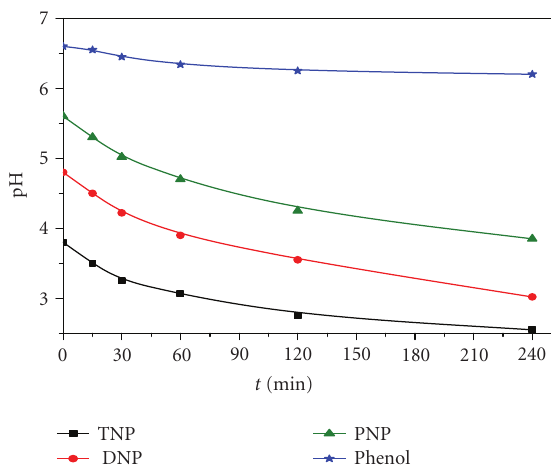
Figure 7: Kinetics of pH variations during the photocatalytic deg- radation of nitrophenols. Experimental conditions: C 0 = 30 mg/L, [P25] = [PC500] = 0.5g/L, V = 1